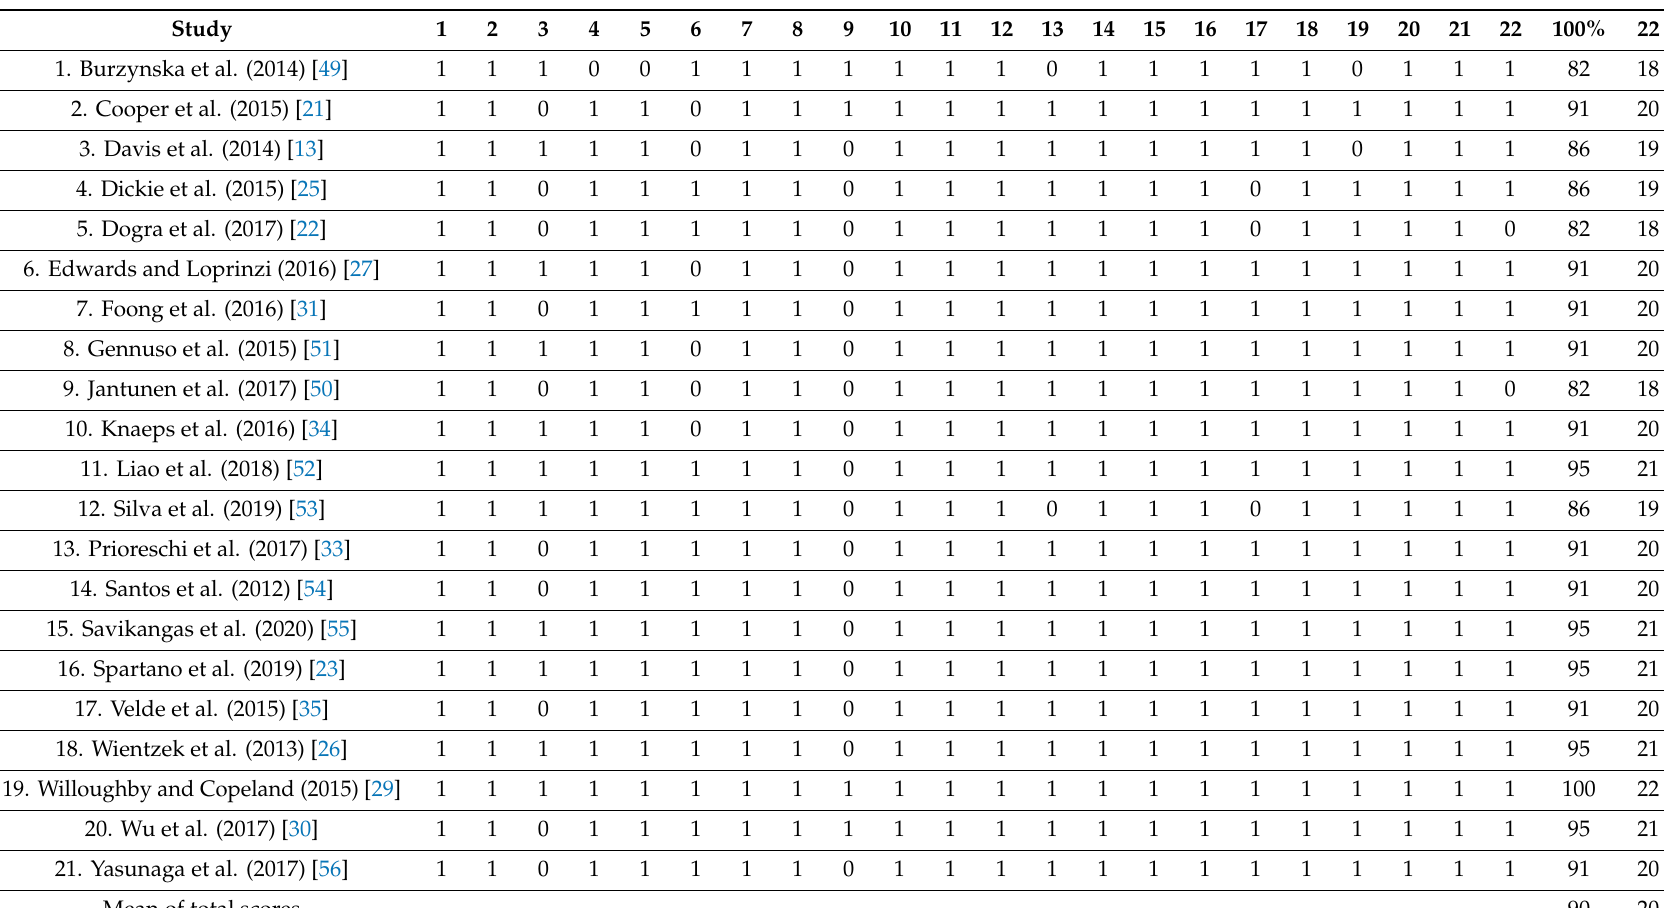
Table 1. Quality assessment scores of selected studies (STROBE